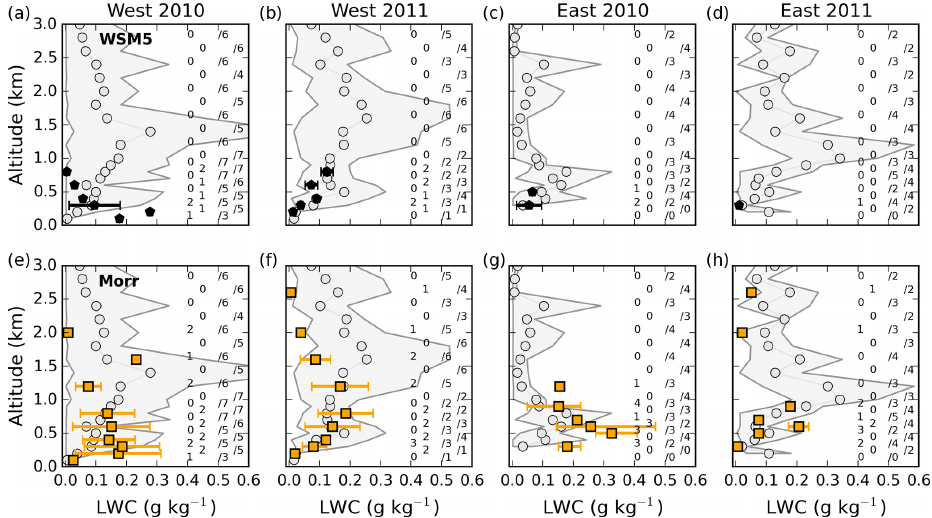
Figure 7. Averaged vertical profiles of non-null LWC for WSM5 (a–d) and the Morrison scheme (e–h) and for the observations west (a, b, e, f) and east (c, d, g, h) of the peninsula. Grey markers indicate the measured average at each altitude, while the shaded area gives the range of the observed flight averages at each altitude. Similarly, coloured markers and error bars relate to the cloud schemes. The numbers indicate how many simulated flight averages were used to derive the global average at each altitude for each scheme, as compared to (“/”) for the observations.